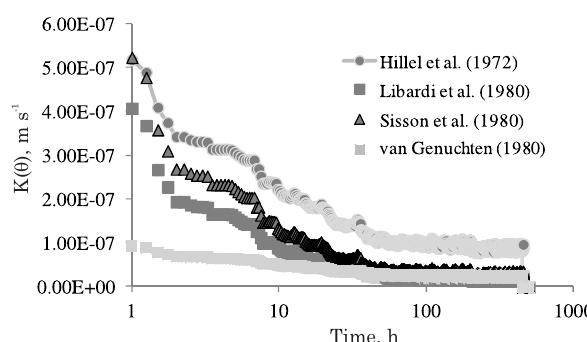
Figure 4. Evolution of the K( θθθθθ ) values estimated by the different methods over